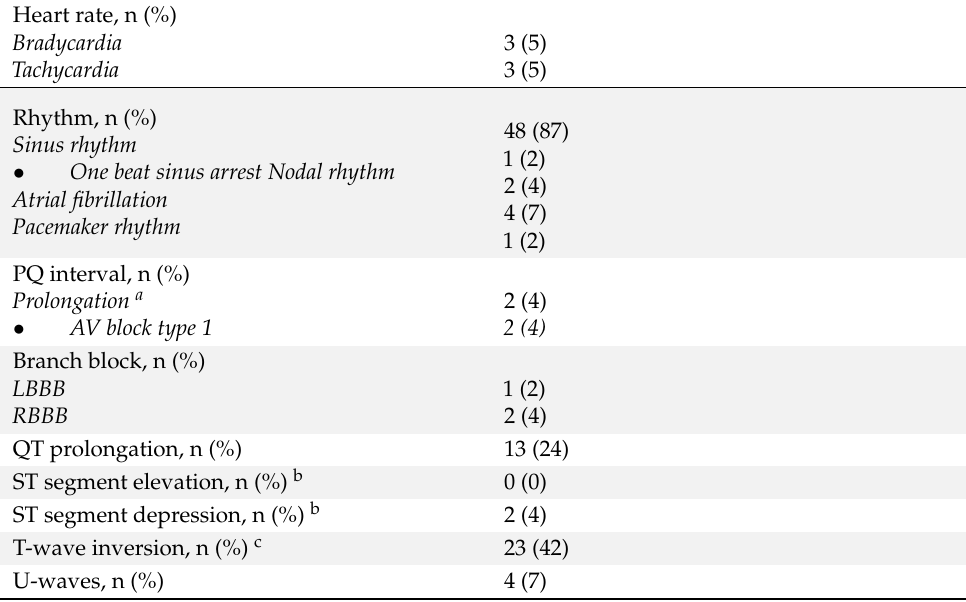
Table 4. ECG changes at time of intoxication (n = 55